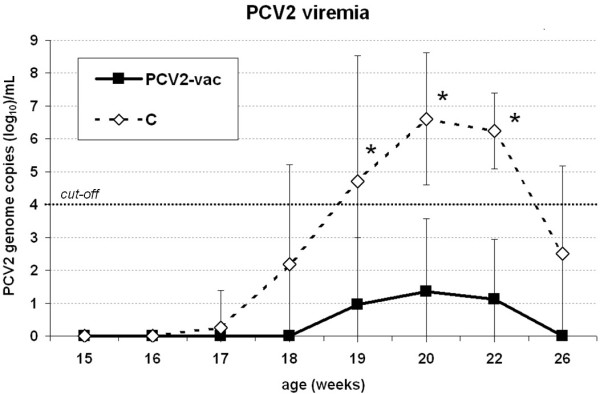
PCV2 viremia upon PCV2 natural infection. PCV2 genome copies (log10)/mL of serum in PCV2-vaccinated (PCV2-vac) and unvaccinated (C) pigs in the post-exposure (PE) period to PCV2 natural infection (15-26 weeks of age) quantified by qPCR. PCV2-vac pigs were vaccinated at 3 weeks of age using a PCV2a Cap protein-based subunit vaccine. (*): statistically significant difference between groups (p < 0.05). The cut-off value of 4 log10 (104) PCV2 genome copies/mL is assumed as the lowest limit for a productive infection.